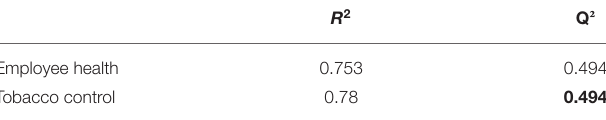
TABLE 6 | R -Square values and Q -Square values for the